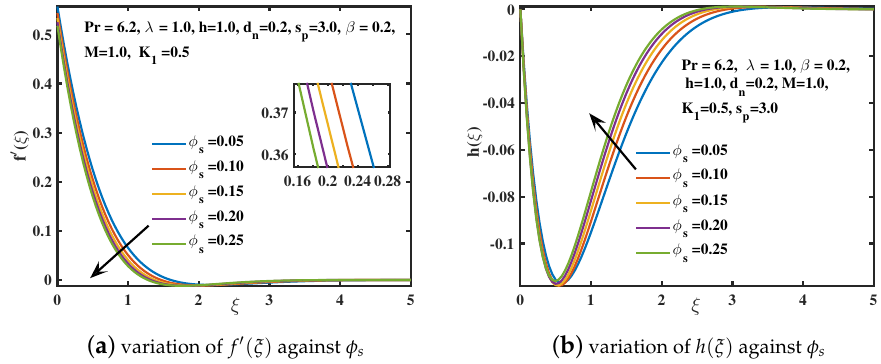
Figure 8. The f (cid:48) ( ξ ) and h ( ξ ) curves for distinct φ s